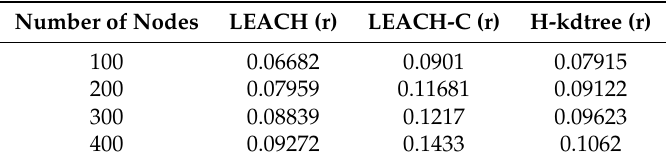
Table 11. Average energy of each node. (r) random.